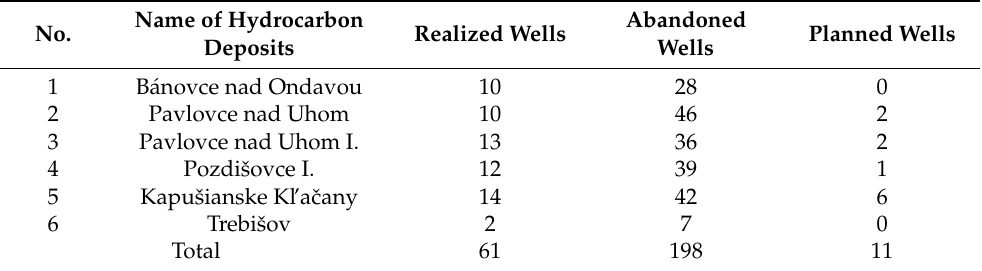
Table 4. Actual state and number of wells in the territory of the Eastern Slovak Lowland, (source: elaborated by